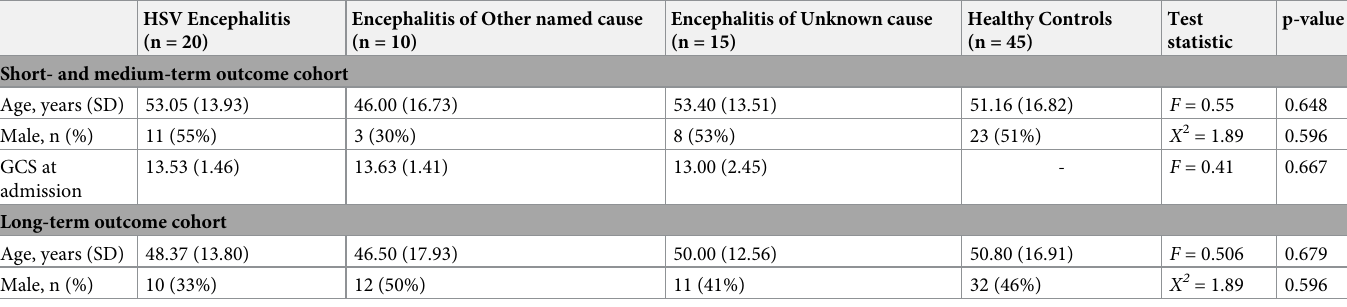
Table 1. Demographic characteristics of patients and controls in the short- and medium-term outcome cohort as well as patients and controls in the long-term out- come cohort. HSV Encephalitis (n = 20)